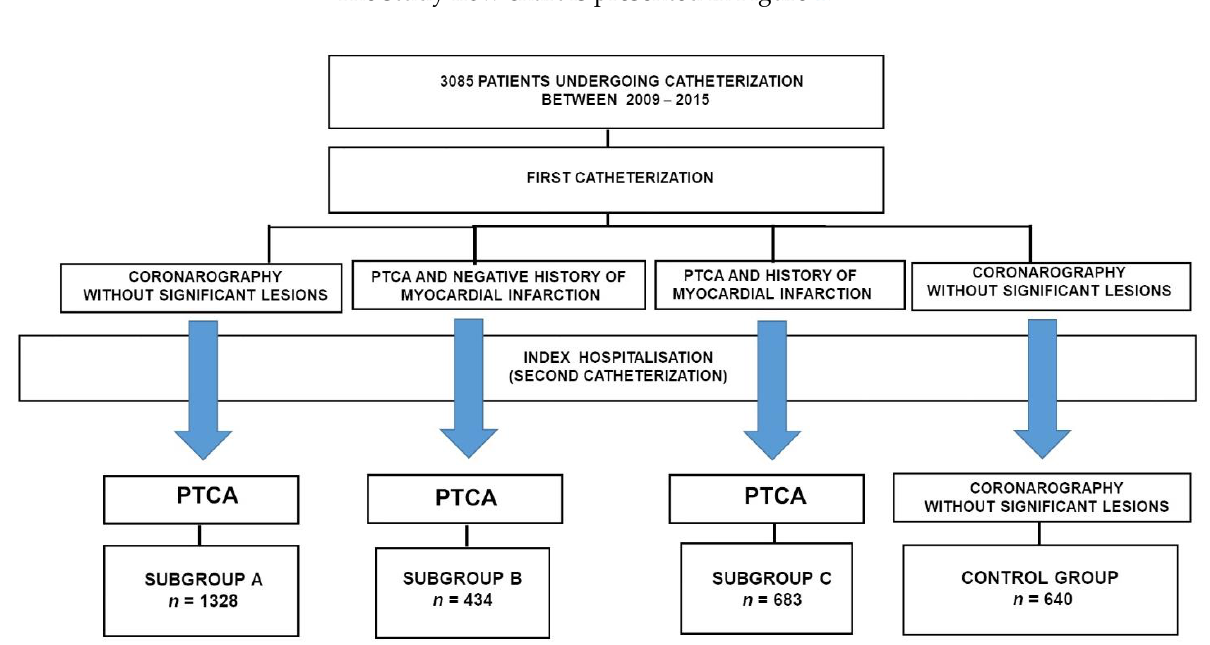
Figure 1. Flow chart of the study. PTCA — Percutaneous transluminal coronary angioplasty.